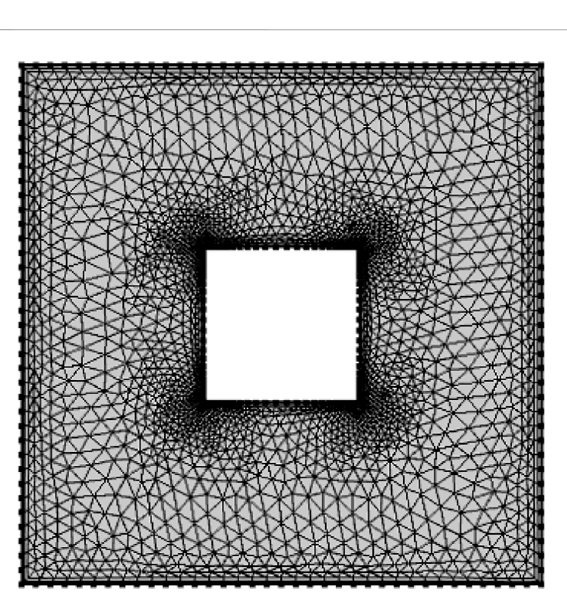
FIGURE 2 Fine grid for acavity with asquareblock placed atC (0.5,